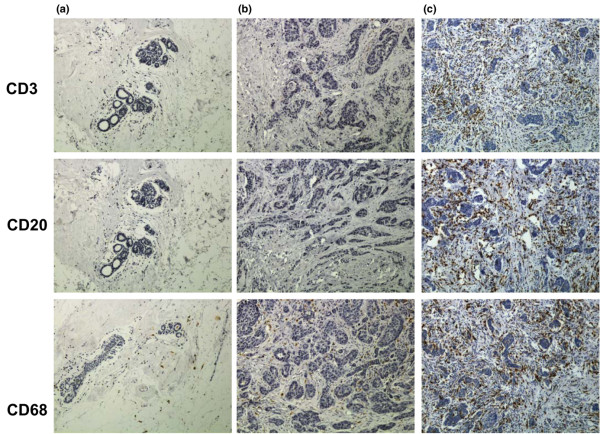
Breast tumours exhibit various levels of leucocyte infiltration. Normal breast and breast carcinoma were stained for B lymphocytes, T lymphocytes and macrophages using CD3, CD20 and CD68 immunostaining. Representative pictures of (a) normal breast, (b) tumour with weak leucocyte infiltration and (c) tumour with robust leucocyte infiltration are shown here.